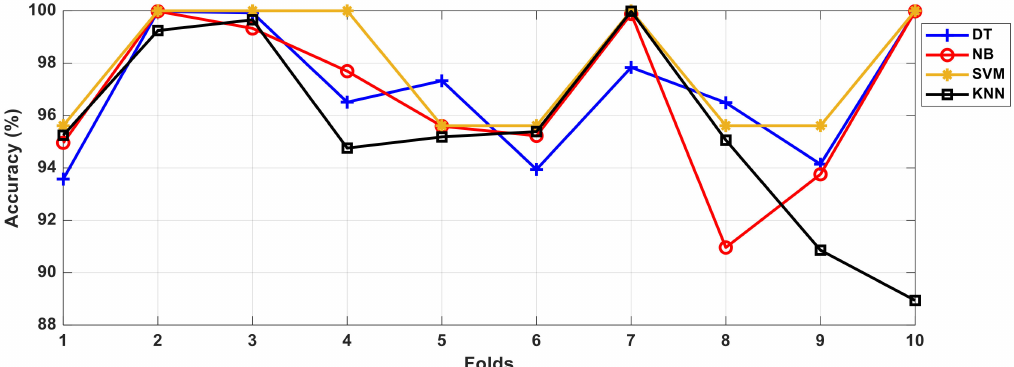
Figure 8. Comparison of the values for Fold-1, Fold-2, Fold-3, Fold-4, Fold-5, Fold-6, Fold-7, Fold-8, Fold-9, and Fold-10 from the 10-fold cross validation